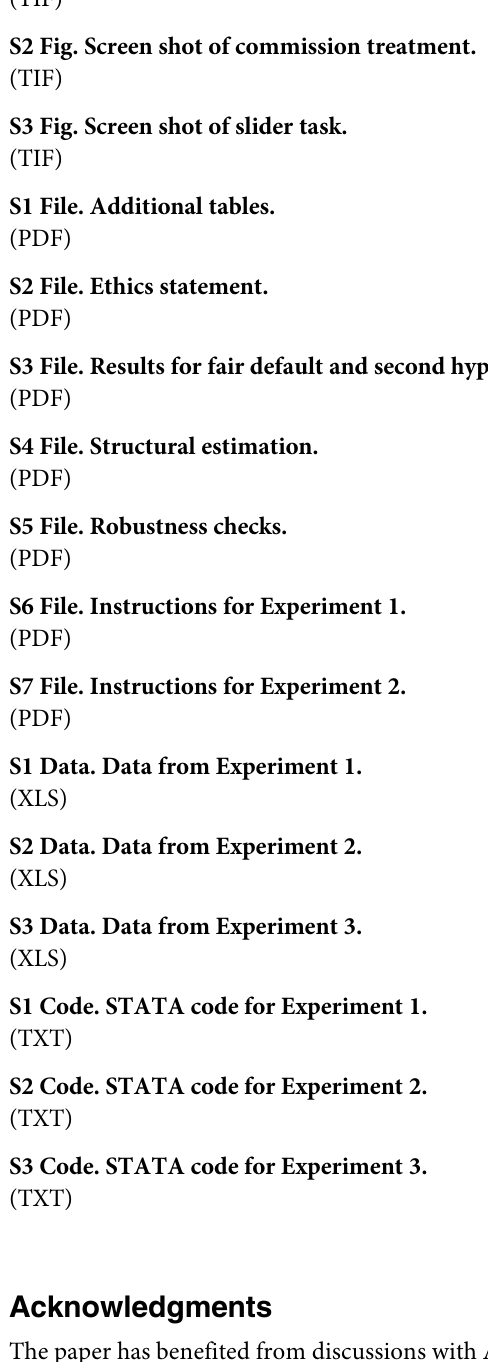
S1 Fig. Screen shot of omission treatment. S2 Fig. Screen shot of commission treatment. S3 Fig. Screen shot of slider